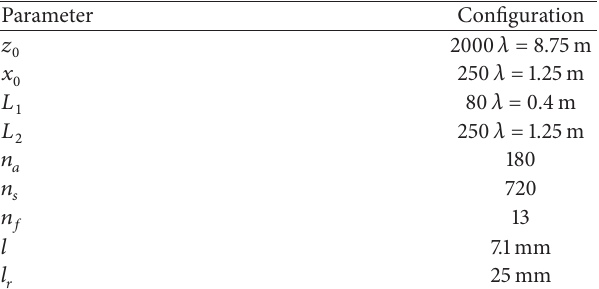
Table 1: Parameters for the numerical